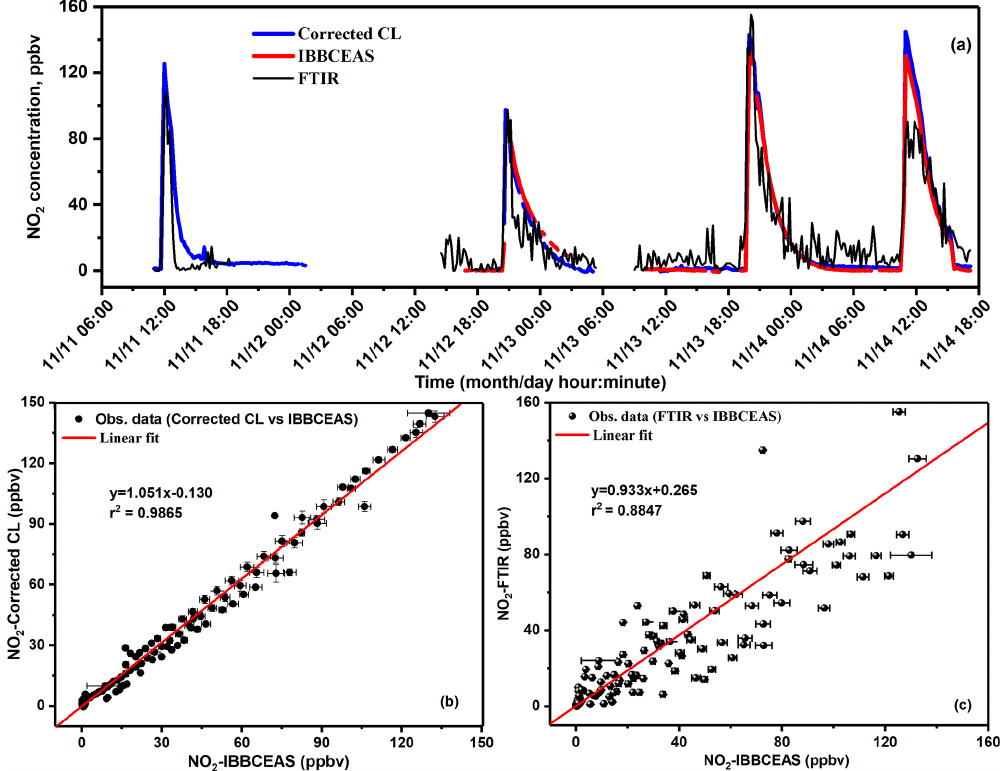
Figure 7. (a) Intercomparison measurement for NO 2 detection between IBBCEAS, FTIR and NO x analyser after HONO interference cor- rection; (b) correlation of the measured NO 2 concentrations between UV-LED-IBBCEAS and NO x analyser (CL) with HONO interferences correction; (c) correlation of the measured NO 2 concentrations between UV-LED-IBBCEAS and